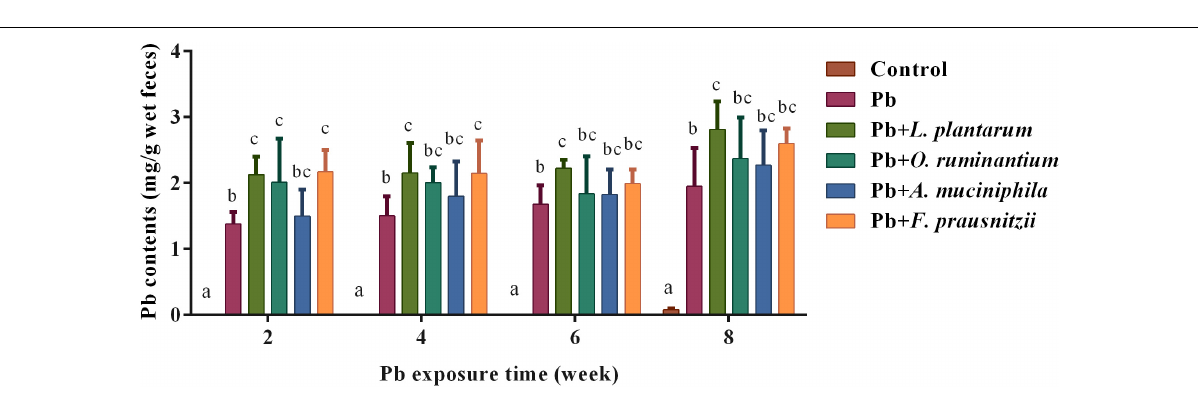
FIGURE 3 | The effects of Pb-intolerant gut microbes on Pb concentrations in the liver (A) , kidneys (B) , brain (C) , small intestine (D) , and blood (E) of chronically Pb-exposed mice ( n = 6). Letters a–d denote statistically significant differences between each group ( p < 0.05).